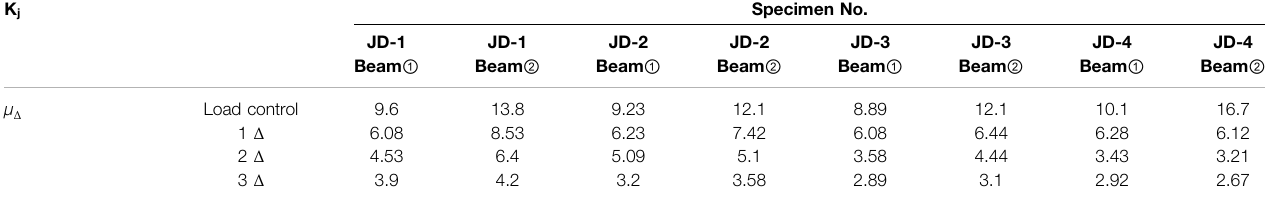
TABLE 6 | Circular